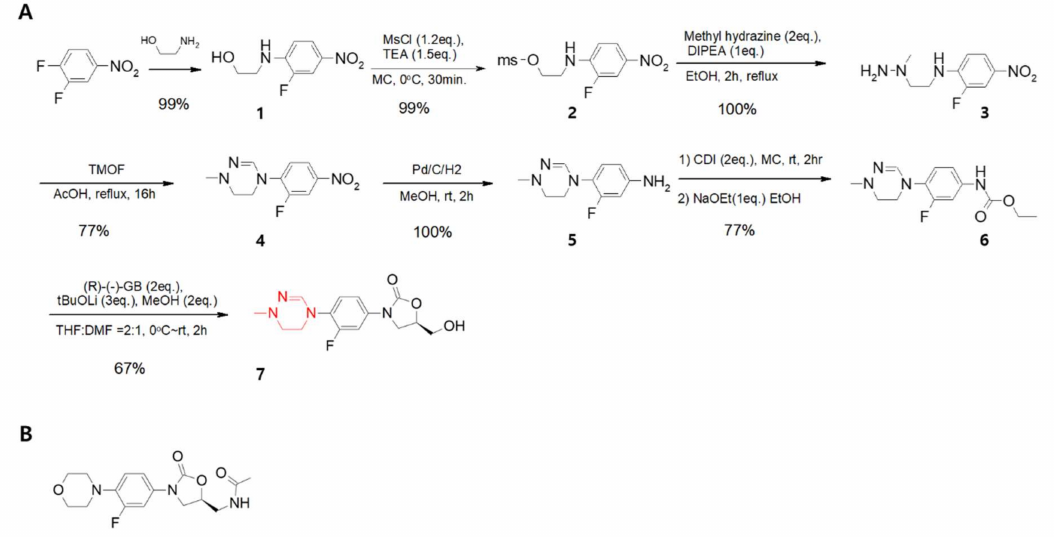
Figure 1. ( A ). Synthetic scheme showing that delpazolid can be synthesised in only seven steps with difluoro-nitrobenzene as the starting material. Each step shows a high yield and the products are easily purified without chromatography. The red color indicates cyclic amidrazone. ( B ). Chemical structure of